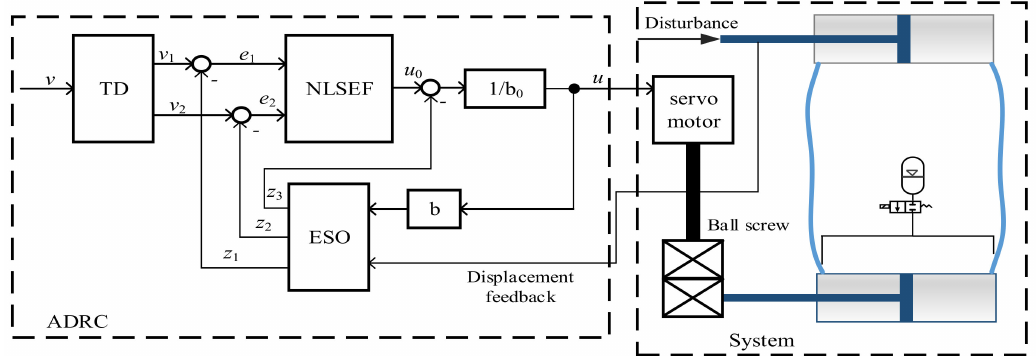
Figure 5. Schematic diagram based on active disturbance rejection control